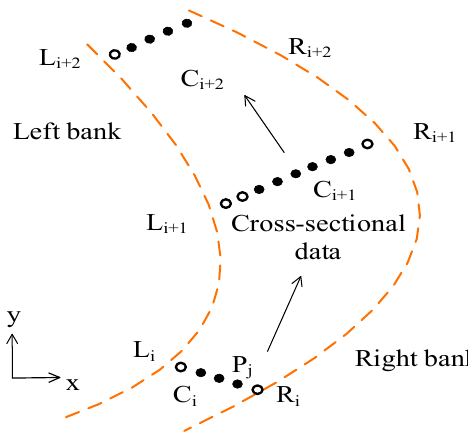
Figure 3. Boundary extrapolation of cross-sectional data.